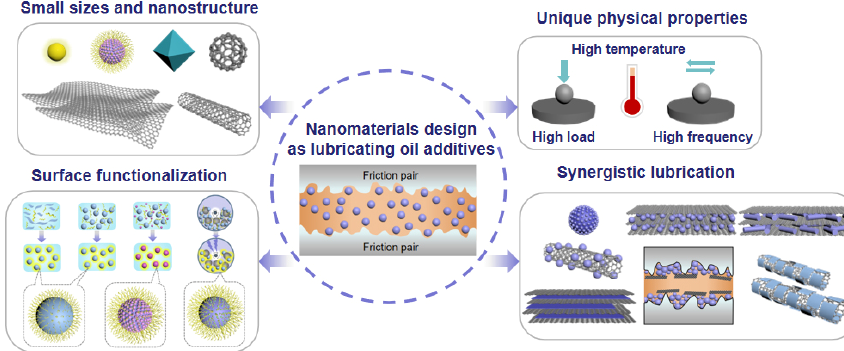
Fig. 3 Categories for nanomaterials design as lubricating oil